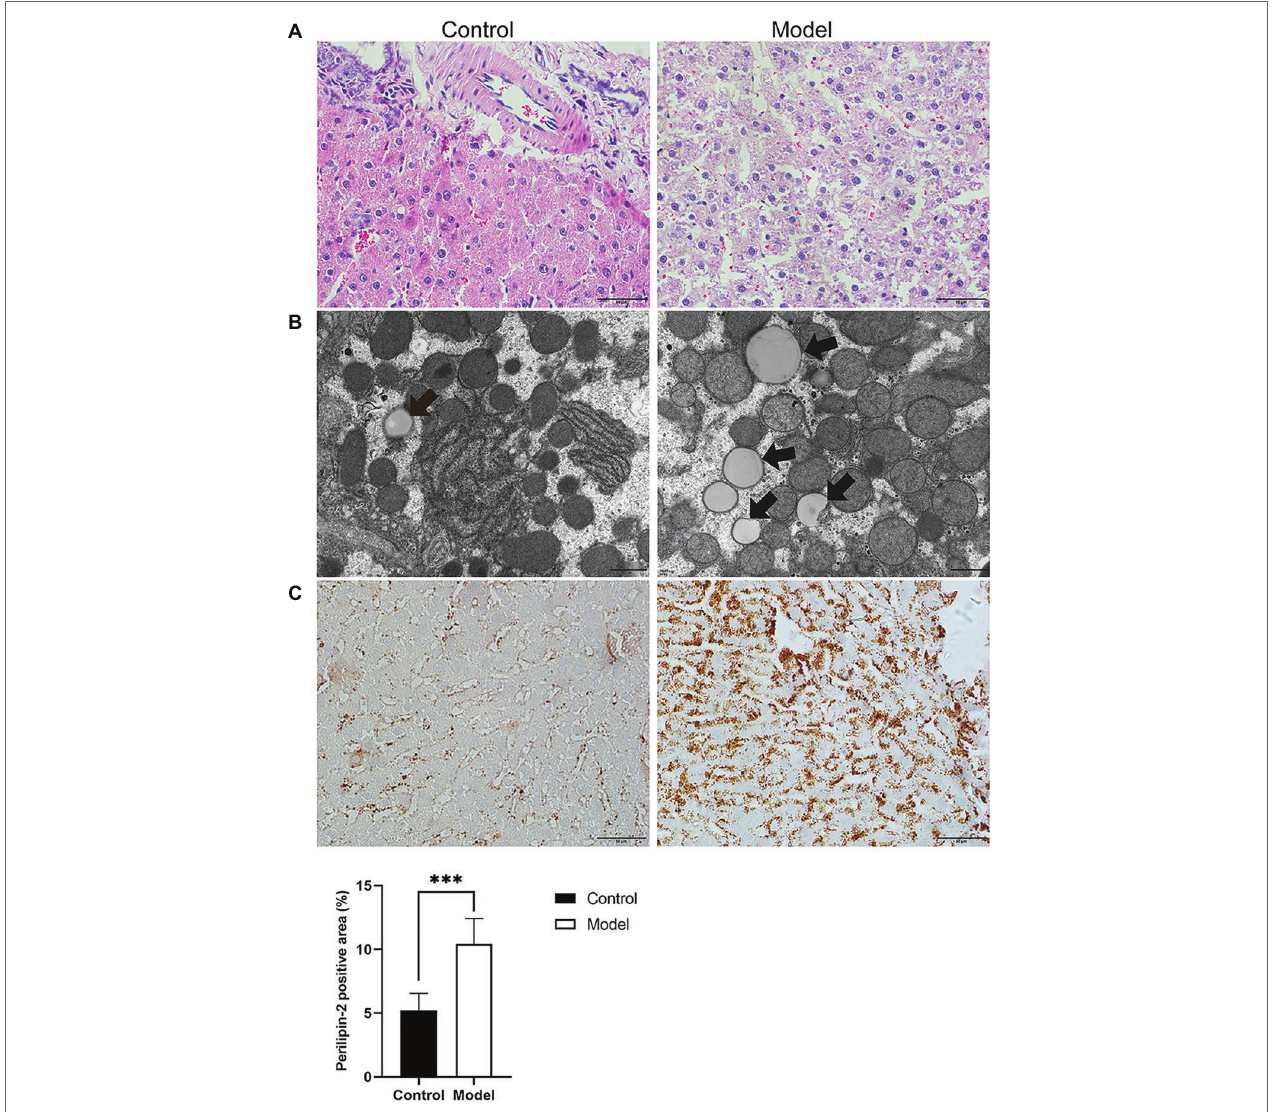
FIGURE 2 | Histopathology, immunohistochemistry, and transmission electron microscopy (TEM) were performed to determine the degree of hepatic steatosis. (A) Hematoxylin-eosin (HE) staining of the liver showed steatosis of most hepatocytes in the model group (scale bar: 50 μ m). (B) Lipid droplets in hepatocytes were examined by TEM (scale bar: 1 μ m). (C) Immunohistochemical staining for Perilipin-2 was observed predominantly in hepatocytes, where positive staining was brown-yellow (scale bar: 50 μ m). The results were obtained from two independent experiments and are expressed as the mean ± SD, n = 8 per group, *** p <